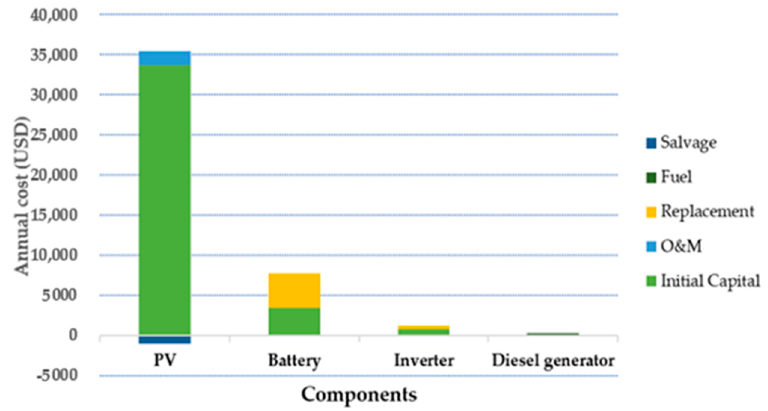
Figure 8. Total annual cost (TAC) break-down by cost type and component.